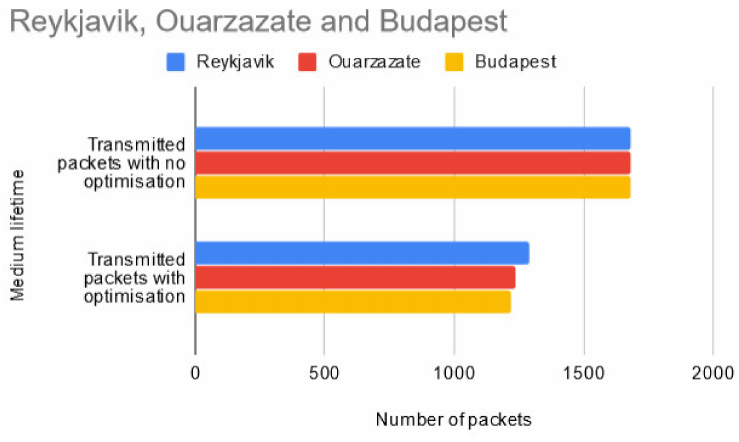
Figure 9. Test results for medium network lifetime